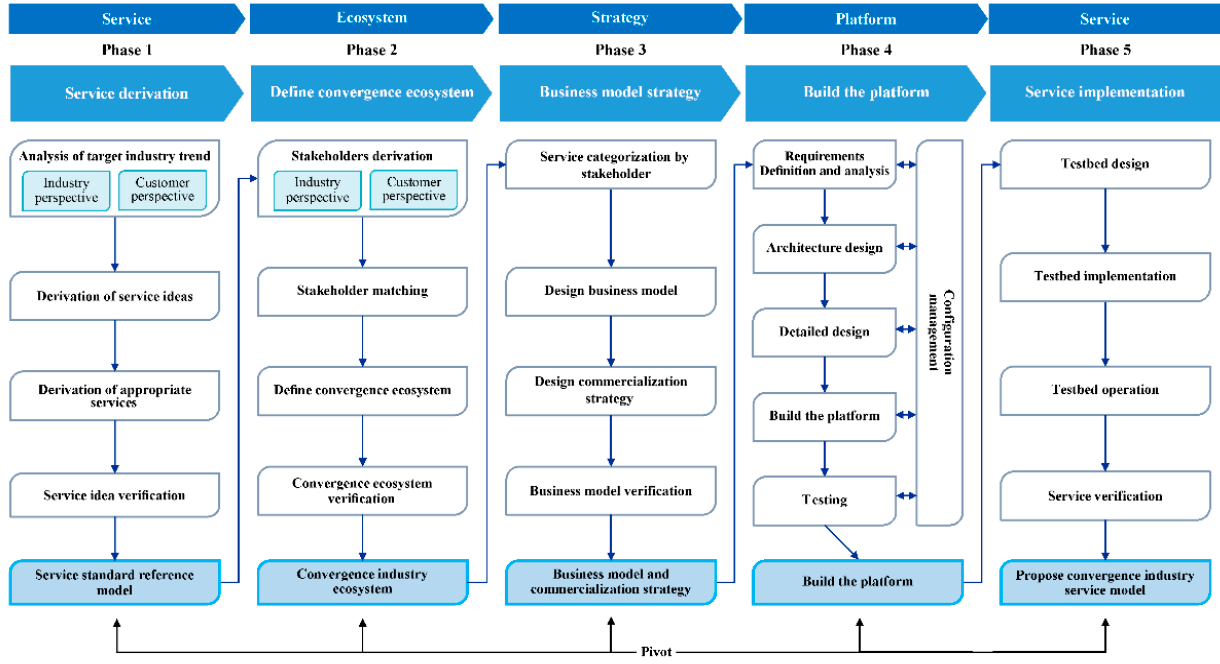
Figure 1. EPSS Figure 1. EPSS framework.